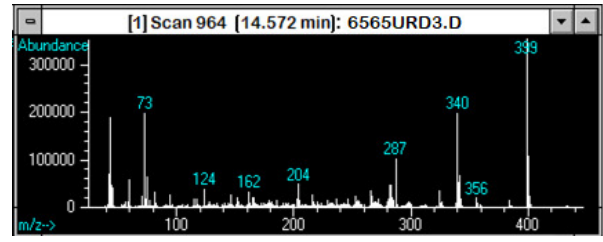
Figure 3. Mass spectrum of